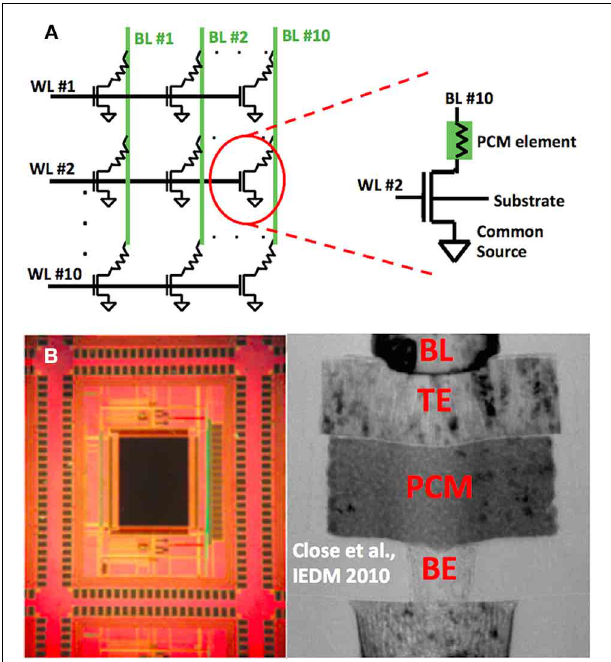
FIGURE 1 | (A) Schematic of 10 × 10 phase change memory (PCM) cell array is shown on the left. Resistances connected in series with the selection transistors represent PCM element. The figure on the right shows the complete schematic of a single memory cell. This particular cell can be accessed by applying appropriate biases at WL #2 and BL #10. Substrate and common source terminals are grounded during the experiment. (B) Optical microscope image of memory cell array located on the memory chip is shown on the left. TEM image of a single memory cell is appended to the right hand side. Mushroom type cell structure can be seen by observing the bitline (BL), top electrode (TE), phase change material (PCM) and bottom electrode (BE) stack (BE) stack. TEM image is reprinted with permission from Close et al. (2010) Copyright 2010 IEEE. TEM image is a representative figure for 90nm node mushroom PCM cell, and PCM cells in the array in this paper are 180nm node with the same device structure.